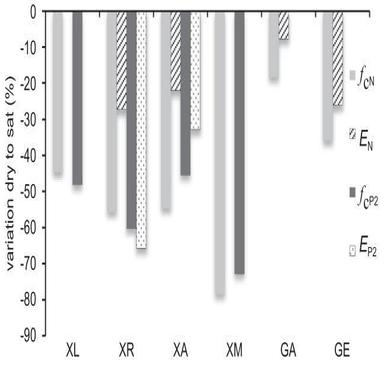
Variation of fc and E dry to saturated results (average values).